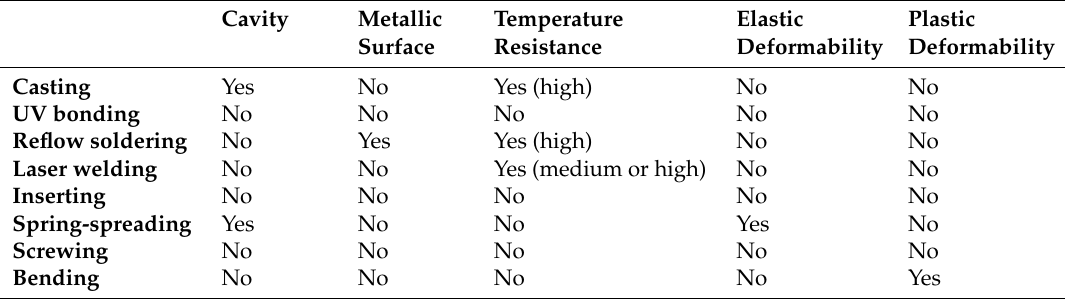
Table 7. Constraint matrix for the component properties.